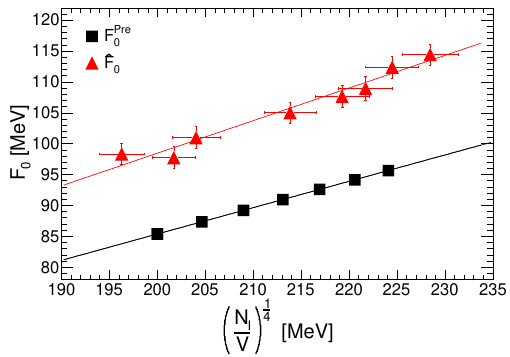
Figure 14 . Comparisons of the numerical re- sults of ^ F 0 with the prediction F Pre . The solid 0 black and red lines indicate the (cid:12)tting results of the prediction and the numerical result, respec-